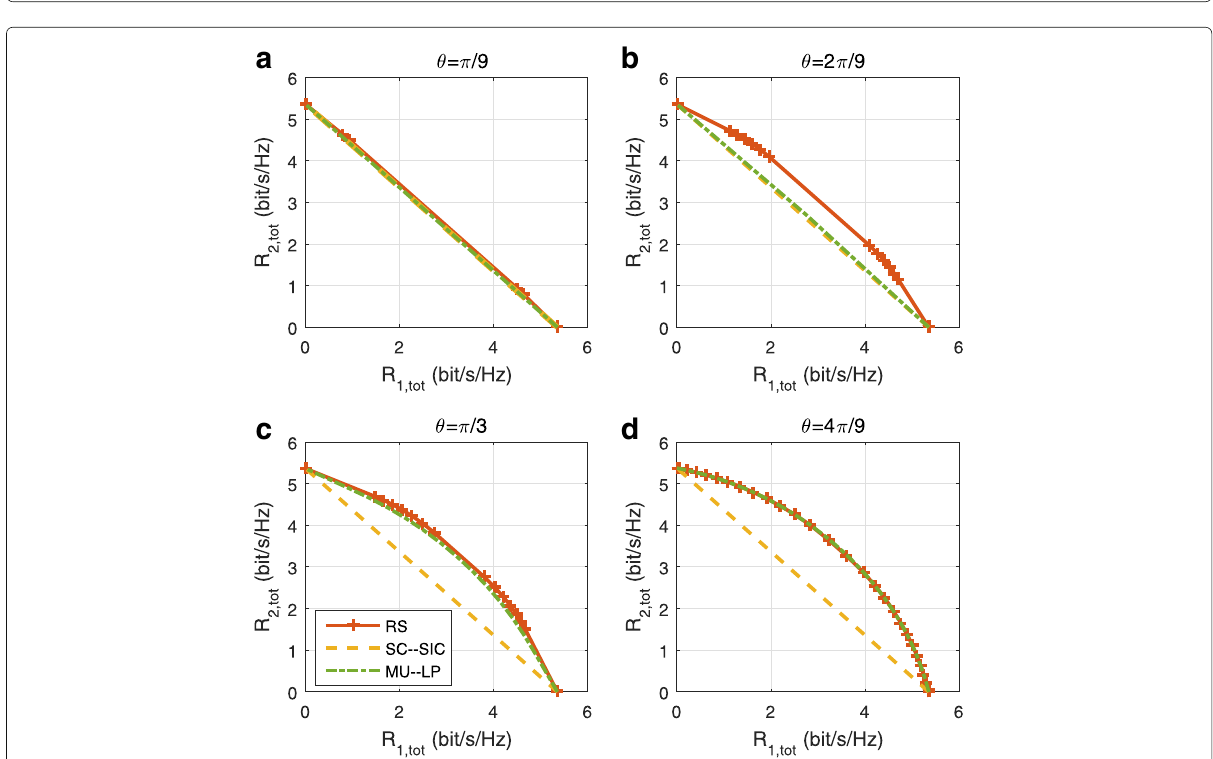
Fig. 26 Average rate region comparison of different strategies in imperfect CSIT, γ = 1, N t = 4, SNR = 10 dB. a θ = π/ 9. b θ = 2 π/ 9. c θ = π/ 3. d θ = 4 π/